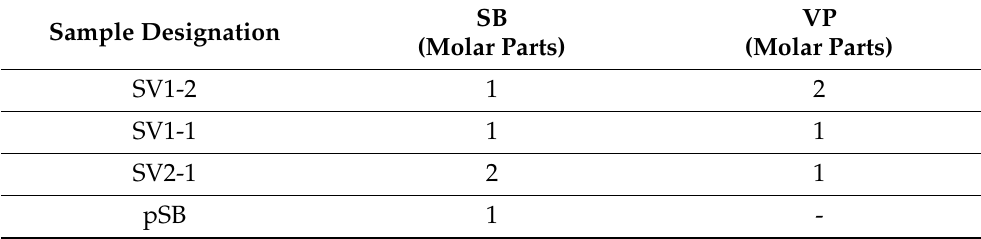
Table 6. Description of pSB-co-pVP